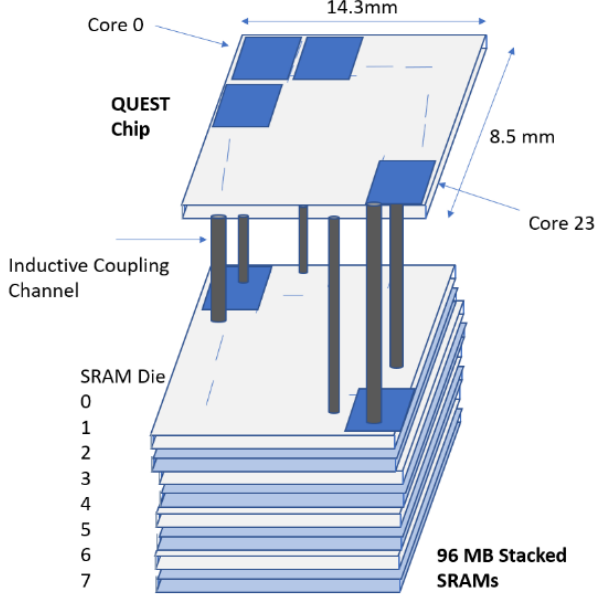
Figure 15. Design structure of QUEST architecture proposed in [12]. Improved efficiency, reduced area, and higher memory bandwidth are the favor- able attributes of log quantization. The multiplications are replaced by additions in log quantization; therefore, it offers reduced area computations compared with linear quan- tization. In this architecture, reconfigurable arrays with bit-serial data lines instead of parallel data paths have been adopted. Therefore, different bit-precision configurations are well-advocated. Also, this methodology allows the utilization of distinct kinds of layers for neural networks with the aid of a unified hardware. Numerous configurations for neural networks are therefore effectively mapped. In this architecture, 3D SRAM has been used as external memory with inductive coupling technique. Stacking of SRAM instead of DRAM offers reduced memory access